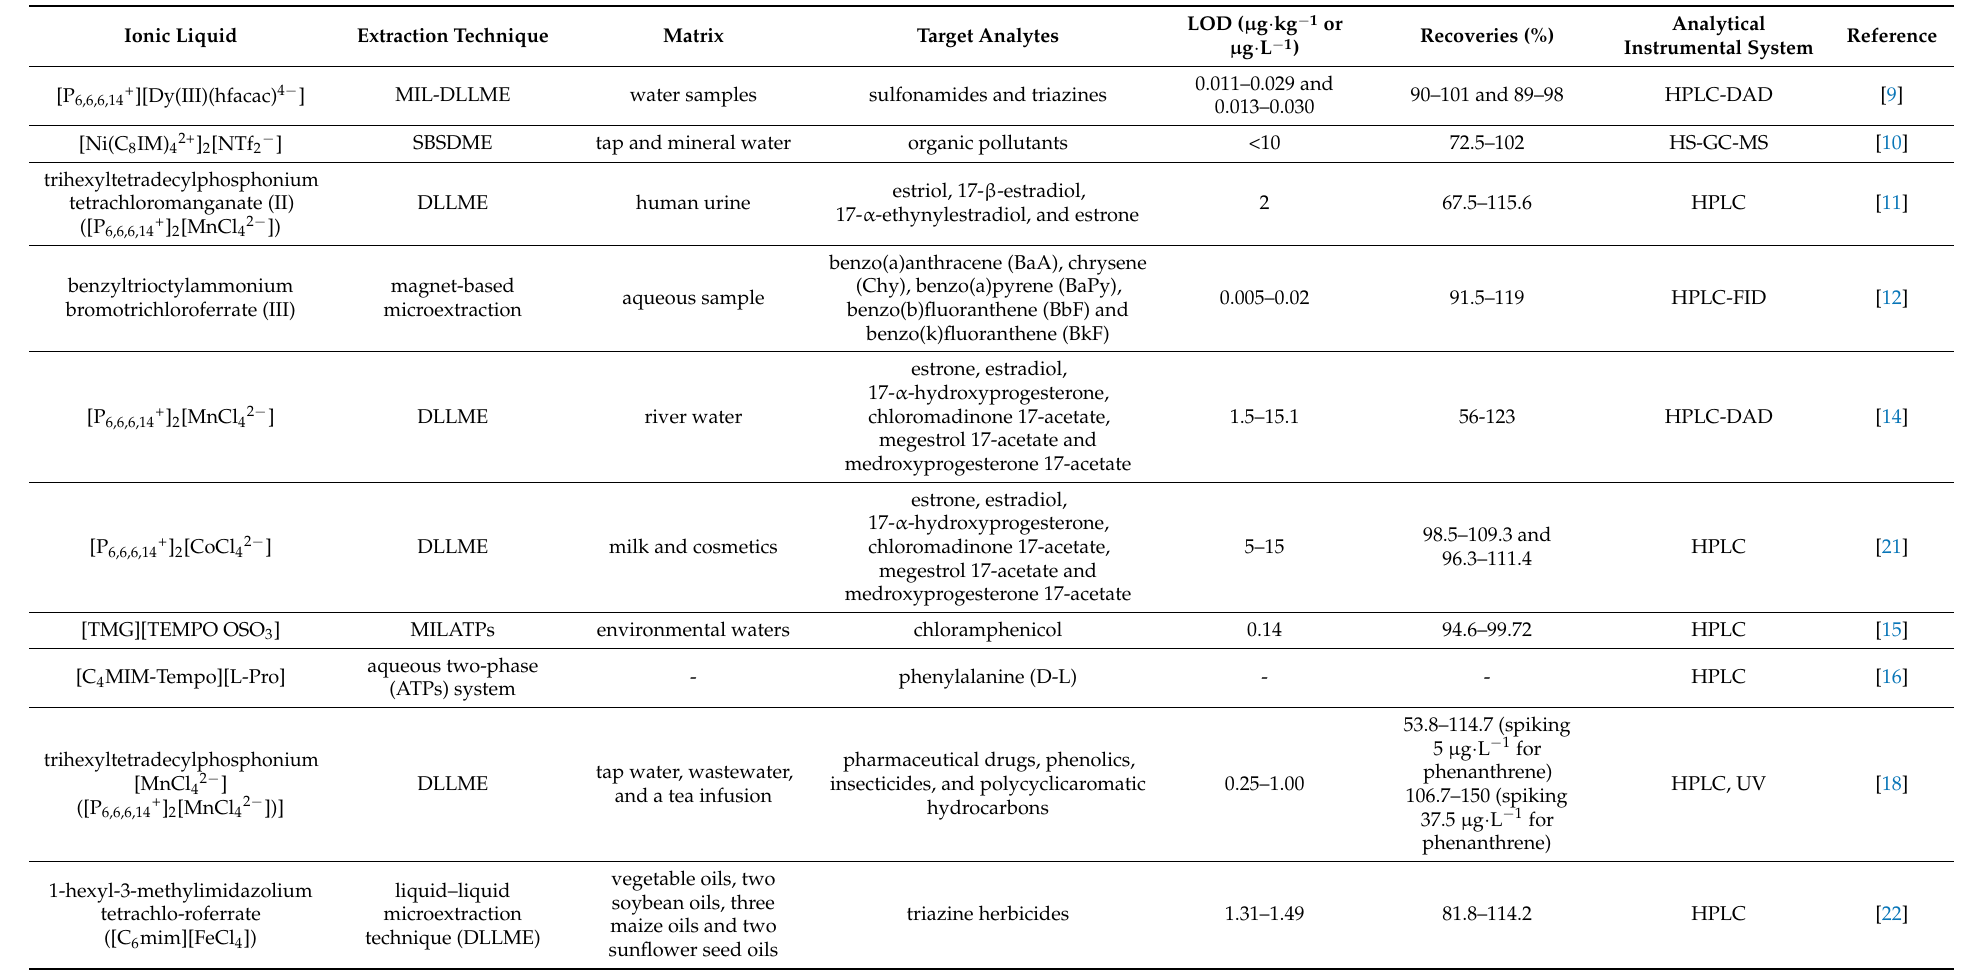
Table 1. Summary of developed analytical procedures based on MILs; LOD: limit of